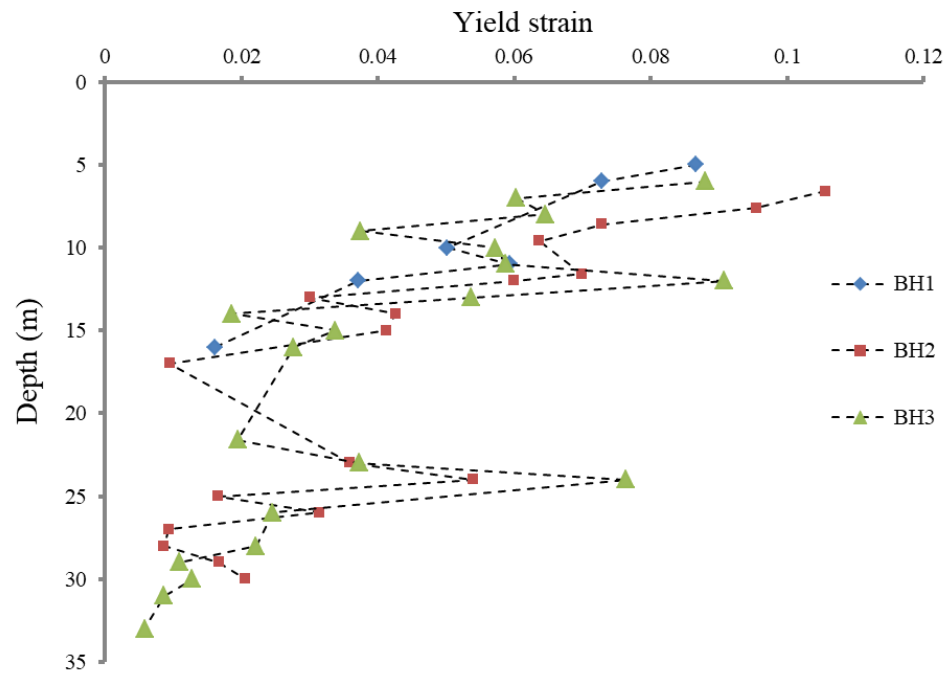
Figure 5. Yield strain distribution for different soils along the depth.